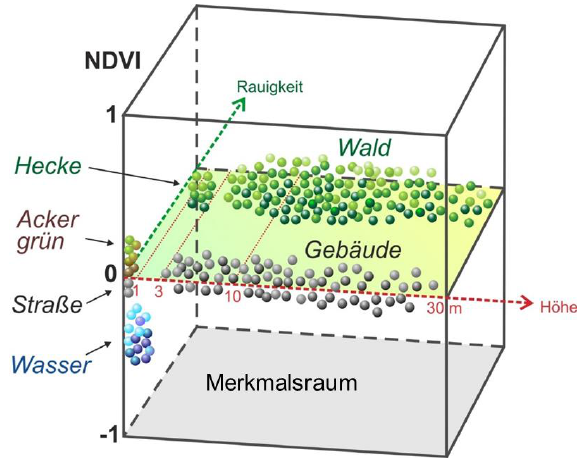
Figure 4. Multidimensional feature space (Rzeznik,